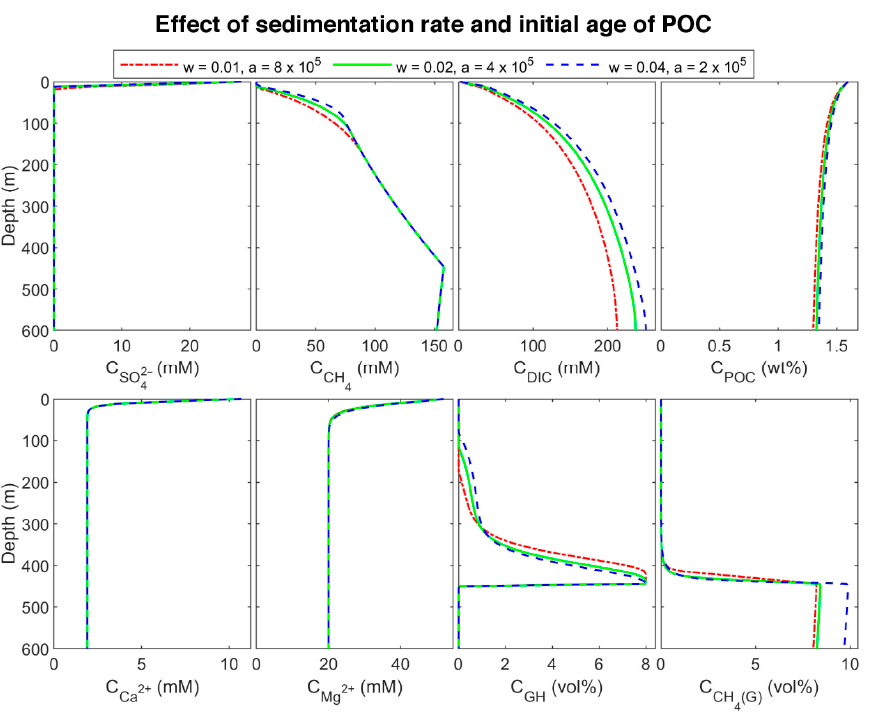
Figure 6. Concentration profile of modeled results at different sedimentation rates and initial ages of POC in the last time step of the model.